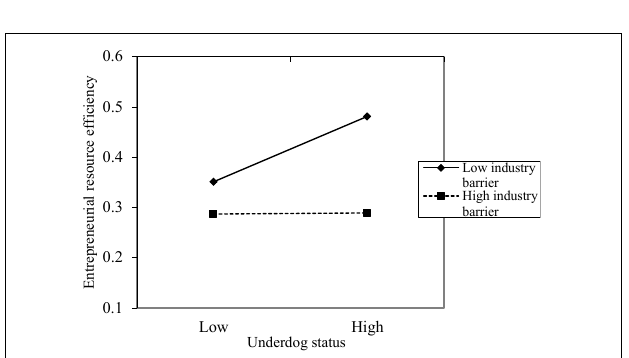
FIGURE 1 | The moderating effect of implicit theory on the relationship between underdog status and entrepreneurial resource efficiency.